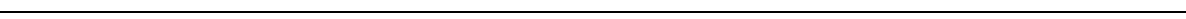
Fig. 7 M cells are dramatically reduced in Peyer ’ s patches after prolonged CSF1R blockade. a Histological analysis of Csf1r -EGFP mice shows CSF1R (green) is not expressed by epithelial cells in Peyer ’ s patches. FAE, follicle-associated epithelium; SED, subepithelial dome; dotted lines indicate the FAE boundary. Scale bar, 100 µ m. b Expression of Csf1r (middle panel) and Gp2 in individual deep CAGE sequence datasets of mouse bone marrow-derived macrophages (BMDM) and M cells 25 . Csf1r mRNA is undetectable in M cells. c – g Mice were treated with anti-CSF1R mAb or control-IgG (control) for 6 weeks before subsequent analysis. c Peyer ’ s patches were whole-mount immunostained to detect GP2 (green), UEA-1 (red) and f-actin (blue). Closed arrows, GP2 + M cells with characteristic basolateral pockets; chevrons, GP2-UEA-1 + goblet cells. The positions of the X – Z and Y – Z projections of the FAE are indicated by the broken lines in the X – Y images. Scale bar, 60 µ m. Boxed areas are shown below in higher magni fi cation. Scale bar, 20 µ m. d Morphometric analysis showed that the density of GP2 + M cells was signi fi cantly reduced after prolonged CSF1R blockade, whereas the density of GP2 − UEA-1 + goblet cells was signi fi cantly increased. Data are mean± SD derived from 10 to 13 mice/group, 1 to 9 FAE/mouse from two independent experiments. *** P <0.001, Mann – Whitney U -test; **** P <0.001, two-tailed unpaired Student ’ s t -test. e Morphometric analysis showed that FAE size was unchanged after prolonged CSF1R blockade. Data are mean±SEM derived from 10 to 13 mice/group, 1 to 9 FAE/mouse from two independent experiments. NS Mann – Whitney U -test. f , g The uptake of particulate antigen ( fl uorescent beads, green) into the Peyer ’ s patches was signi fi cantly impaired in anti-CSF1R-treated mice. Circles highlight individual beads in the SED. Sections counterstained to detect F-actin (blue). Scale bar, 5 µ m. g The number of beads transcytosed across the FAE was signi fi cantly reduced in anti-CSF1R-treated mice. Data represent mean±SD from 6 to 12 sections from 4 mice/group. *** P <0.001, Mann – Whitney U